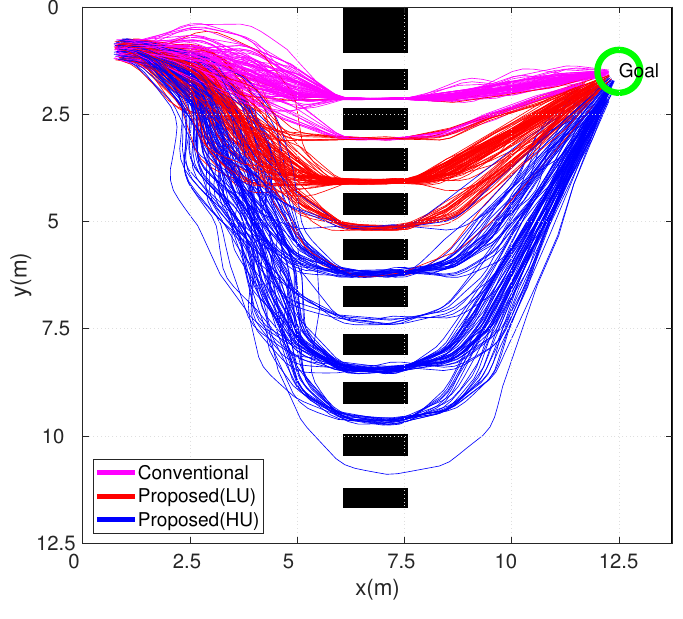
Figure 11. Resultant paths.